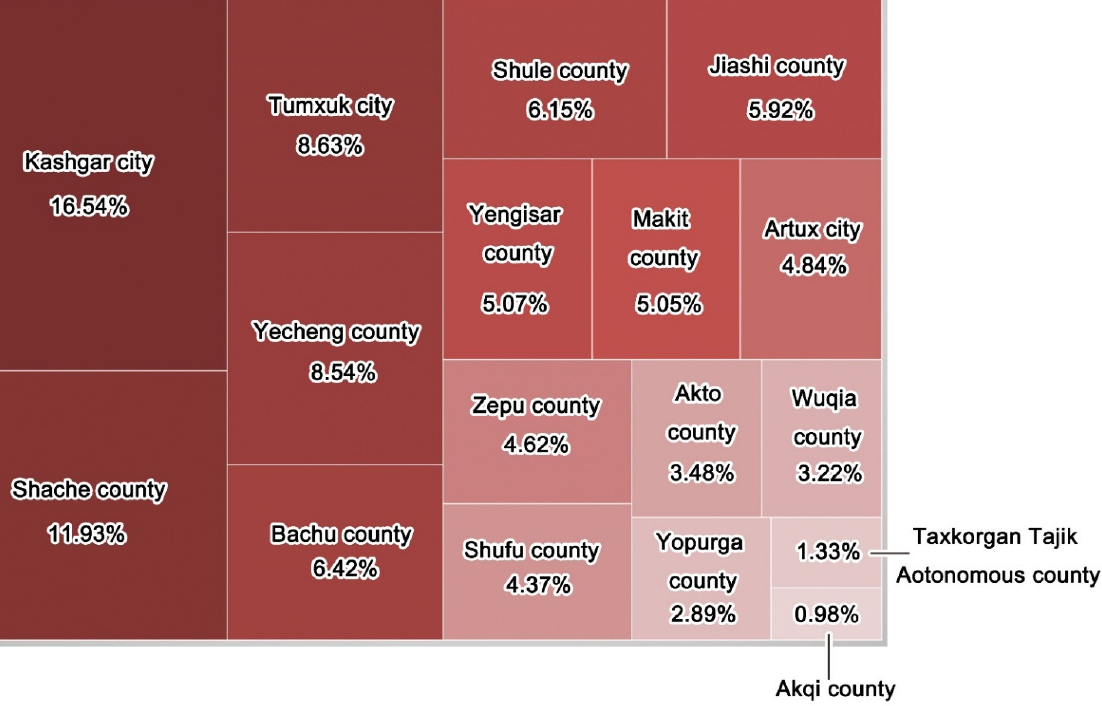
Figure 6. The proportion of GDP of counties and cities in the KMA in 2018.